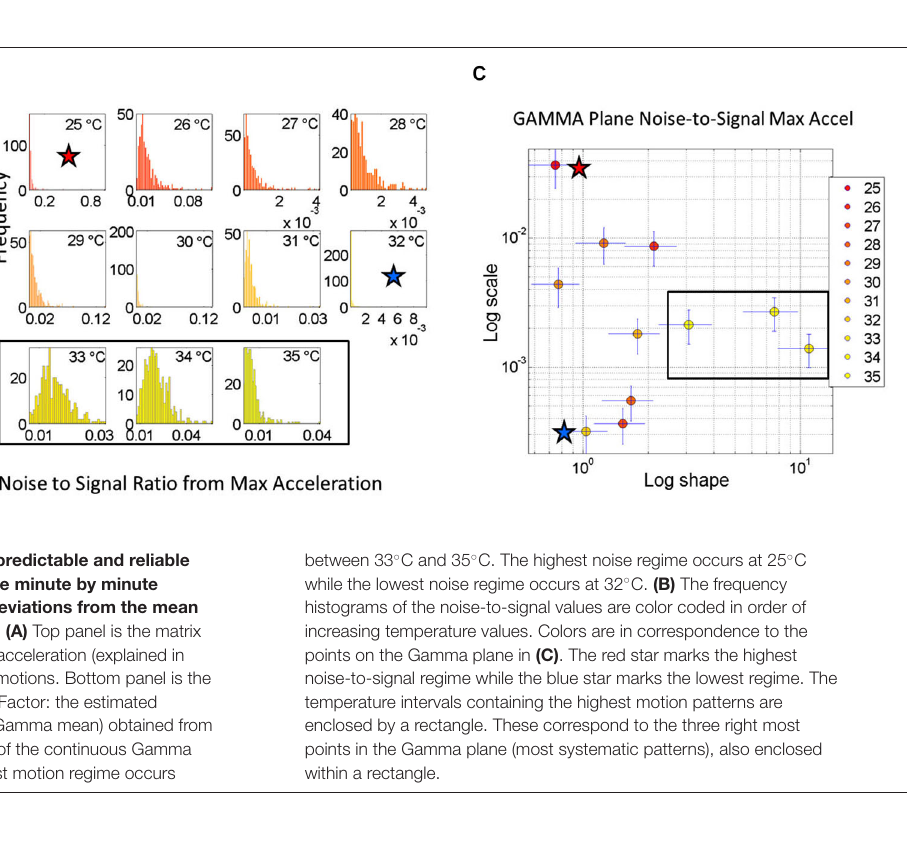
FIGURE 3 | Construction of the matrix containing the sensor data from a registered range of surface skin temperatures: Motion data from the tri-axial linear accelerometers are obtained continuously for each minute of recordings (128 Hz × 60 frames) in 6.26 h (375.6 min) for this session . Each entry of the matrix contains the maximal deviation from the mean